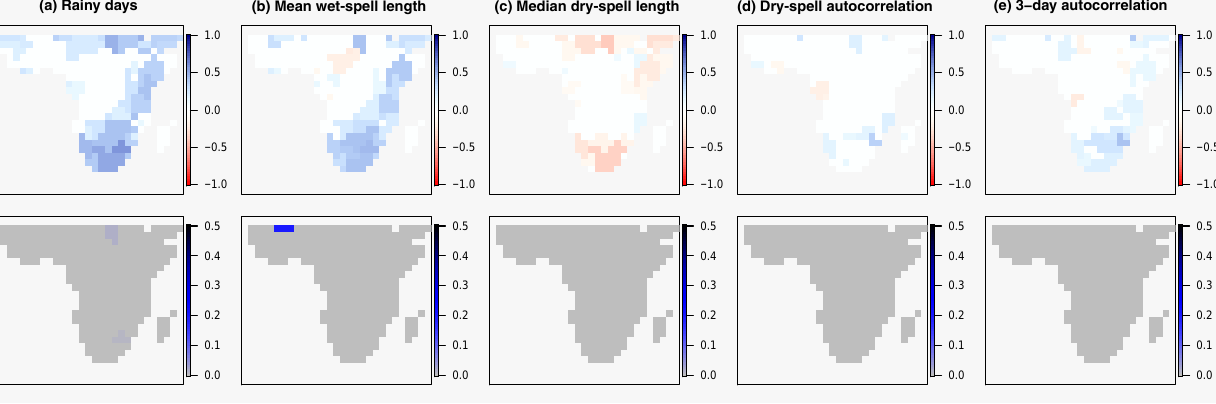
Figure 3. Same as Fig. 2 for the following variables. (a) Rainy days: number of days with more than 1mm of rain. (b) Mean wet-spell length: mean length of consecutive days of rain greater than 1mm. (c) Median dry-spell length: median length of consecutive dry days. (d) Dry-spell autocorrelation: Spearman rank lag-1 autocorrelation of successive dry spell lengths. (e) 3-day autocorrelation: Spearman rank lag-3 autocorrelation of daily rainfall